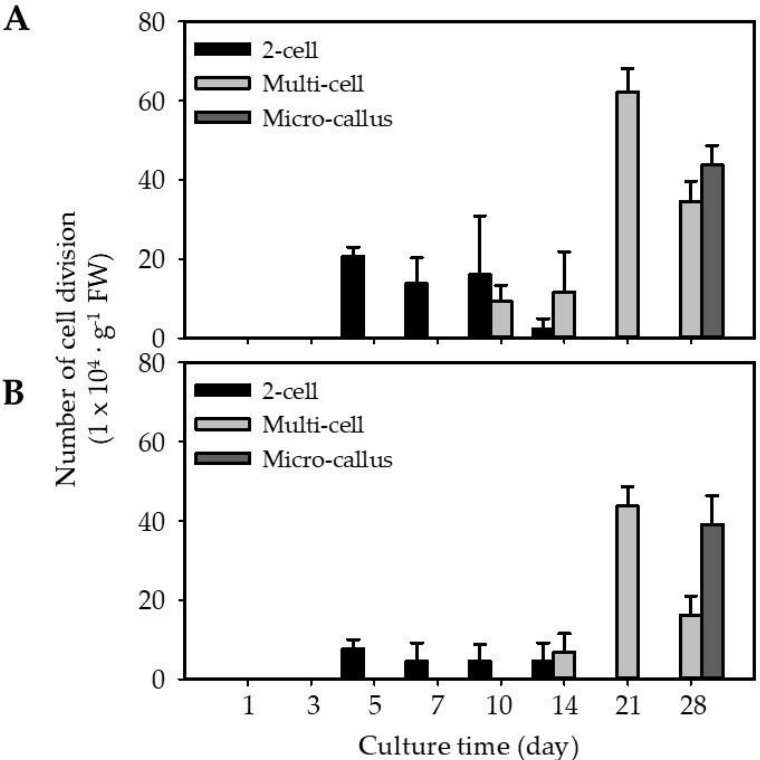
Figure 3. Embedded protoplasts in culture for 4 weeks: ( A ) EC-derived protoplasts; ( B ) NEC-derived protoplasts. Values are expressed as mean ± SD. The error bars represent at least three independent replicates.